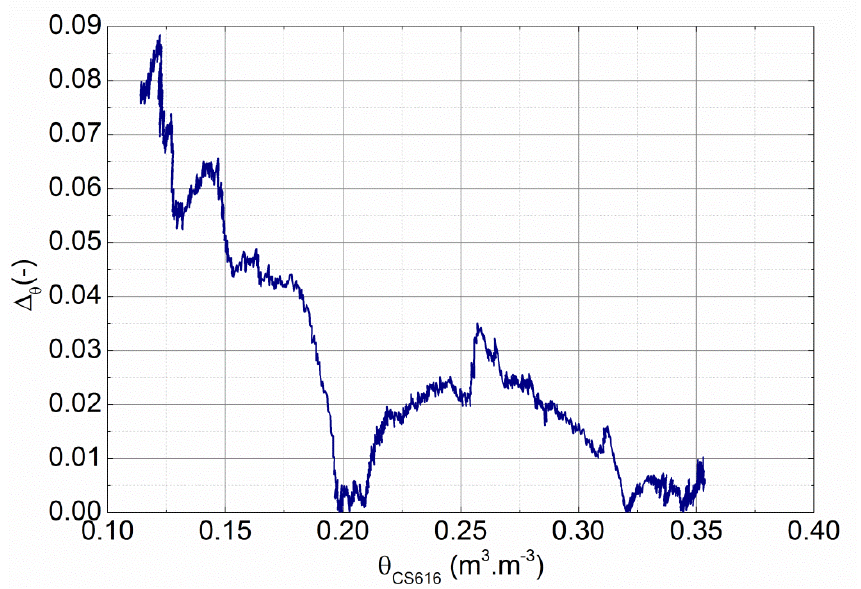
Figure 6. Deviation on the values of volumetric water content between the CS616 and CS650 probes located respectively on the left and right sides 50cm